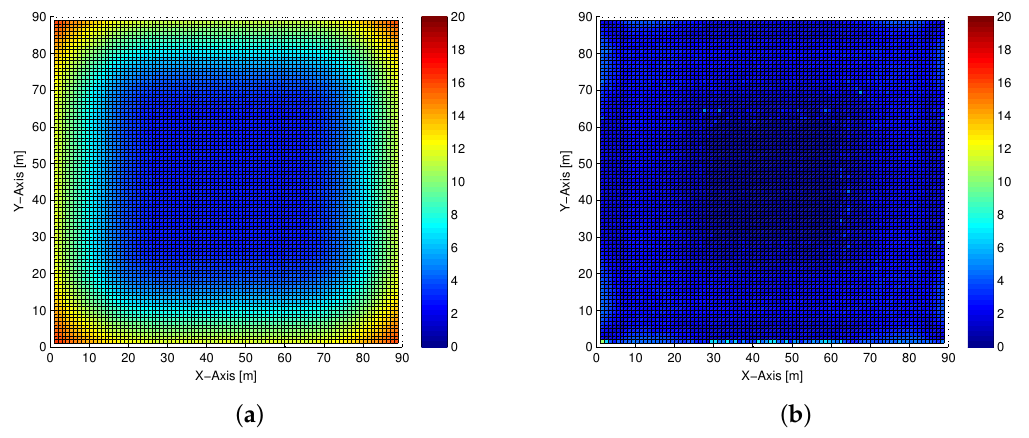
Figure 2. Top view of the distance error using each algorithm. ( a ) C-WCL; ( b ) test node-based WLC